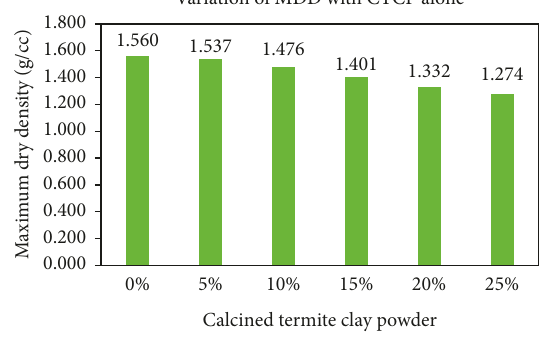
Figure 9: Combined effect of BA and CTCP on the free-swell